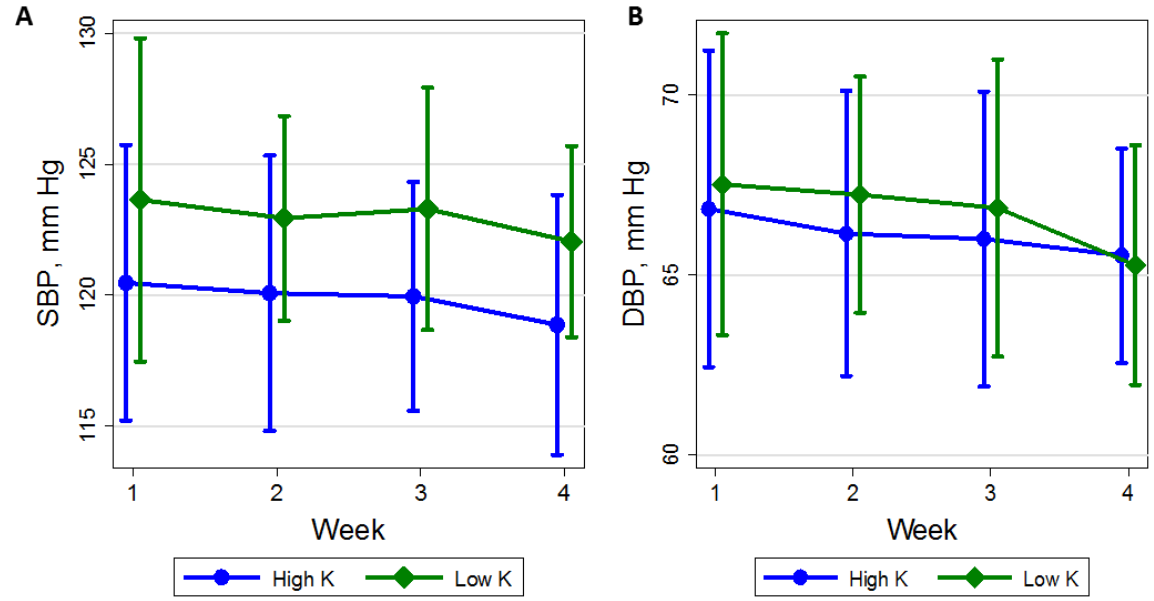
Figure 2. Mean ( A ) systolic blood pressure (mm Hg) and ( B ) diastolic blood pressure with 95% CI (vertical lines) for each week while on either the higher potassium (K) diet (circle) or the lower K diet (diamond). The number of participants contributing measurements by week (1–4) on the two diets were, 25, 25, 25, and 26 for the higher-K diet and 27, 26, 25, and 26 on the lower-K diet. SBP: systolic blood pressure; DBP: diastolic blood pressure.